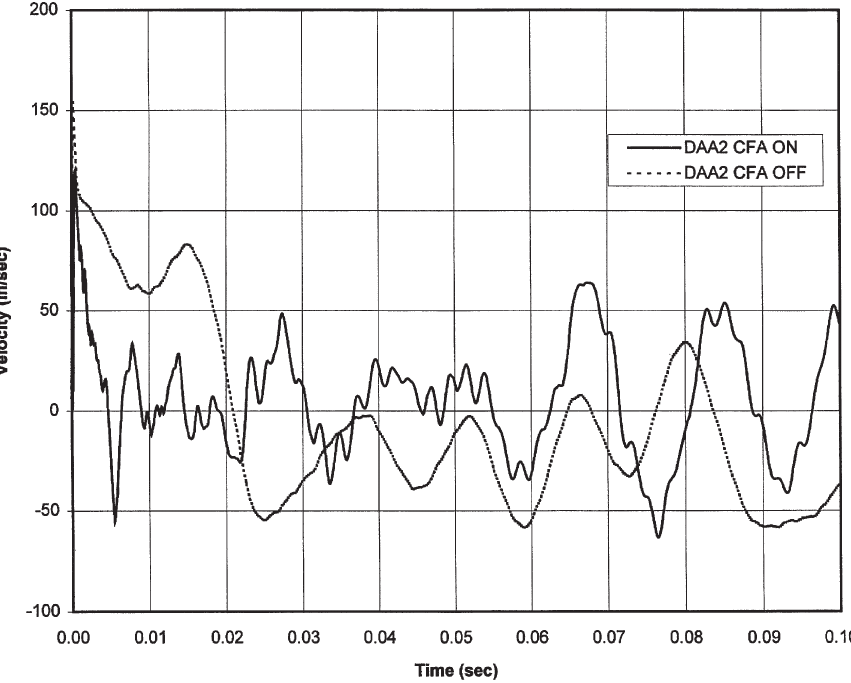
Fig. 10(b). Velocity response at the keel (node 42) for two cases: DAA/CFA-on and DAA/CFA-off.